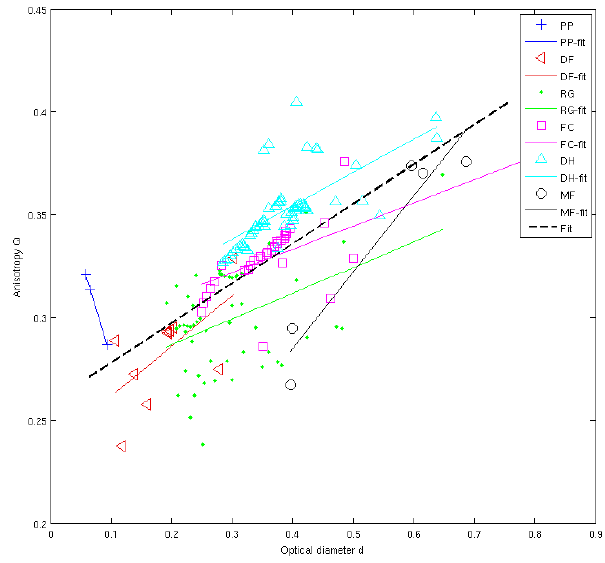
Figure A1. Regression of anisotropy parameter Q to optical diam- eter d within snow type classes in data from Löwe et al. (2013).